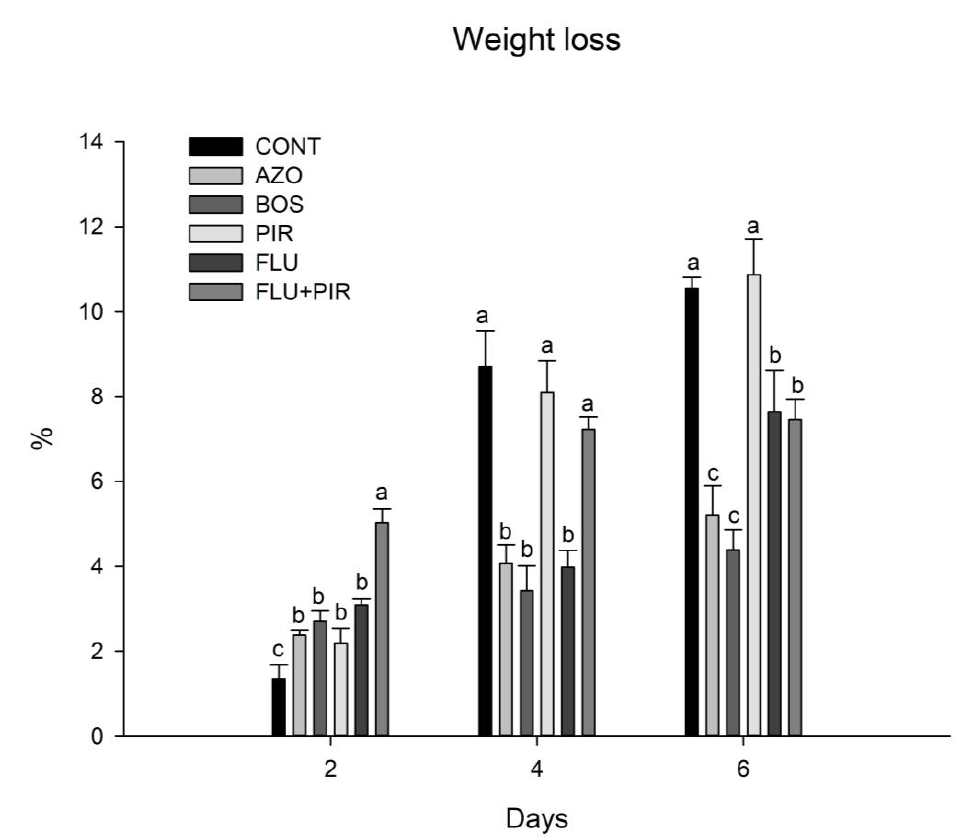
Figure 1. Weight loss on different evaluation days of tomato fruits treated with physiological effect fungicides. Different lowercase letters in the columns in the same evaluation period differ statistically using the Scott Knott test at 5% probability. CONT—Control; AZO—azoxystrobin; BOS—boscalid; PIR—pyraclostrobin; FLU—fluxapyroxad; FLU + PIR—fluxapyroxad + pyraclostrobin.